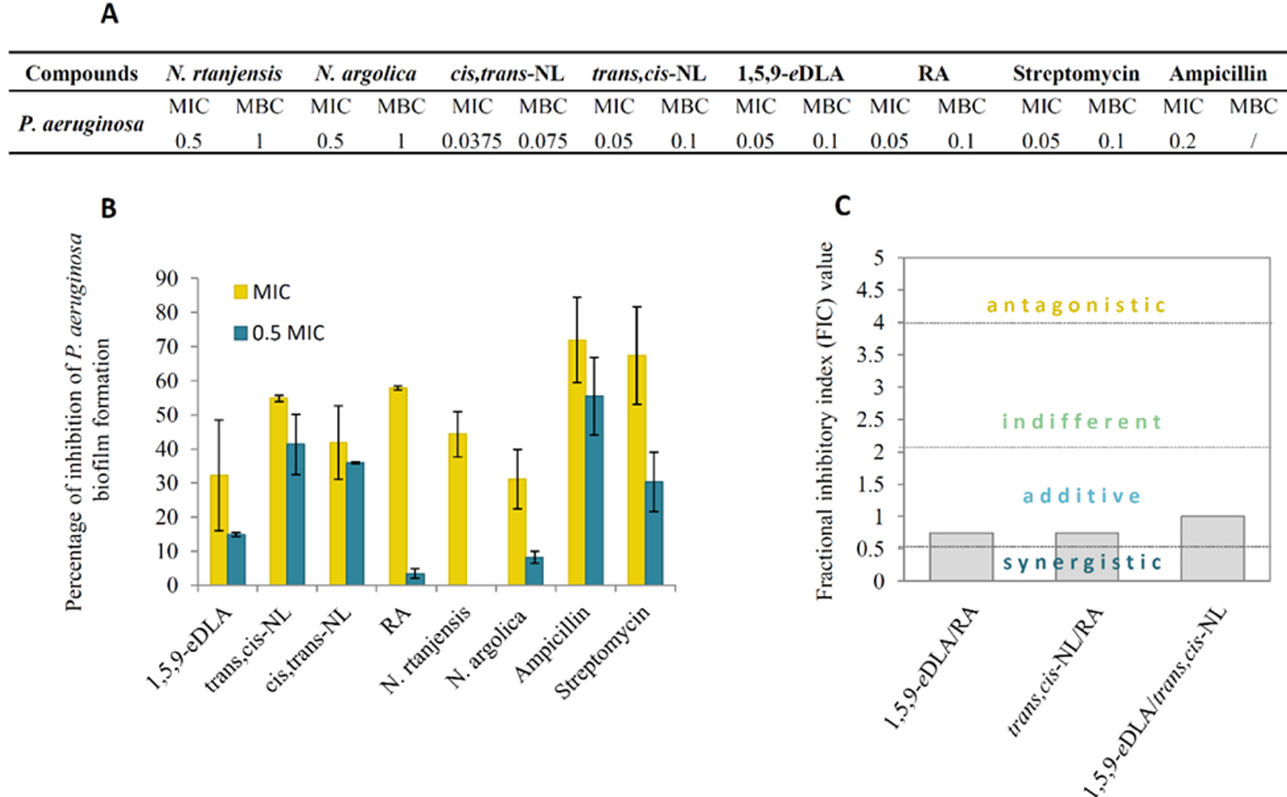
Figure 4. Antibacterial ( A ) and antibiofilm activity ( B ) of Nepeta rtanjensis and N. argolica subsp. argolica methanol extracts, and of cis,trans -nepetalactone ( cis,trans -NL), trans,cis -nepetalactone ( trans,cis -NL), 1,5,9-epideoxyloganic acid (1,5,9- e DLA), and rosmarinic acid (RA) against a resistant P. aeruginosa strain. Minimal inhibitory (MIC) and lethal concentrations (MBC) were determined, and streptomycin and ampicillin were adopted as reference compounds. ( C ) Antibacterial interaction against P. aeruginosa of the following compound combinations: trans,cis -NL/1,5,9- e DLA, trans,cis -NL/RA, and 1,5,9- e DLA/RA.